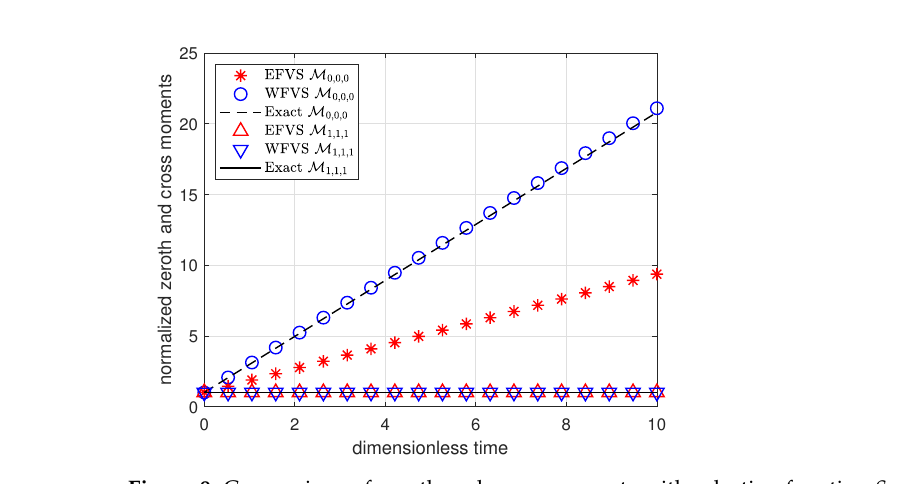
Figure 9. Comparison of zeroth and cross moments with selection function S = ψ ( x ) , and breakage function b 7 . Table 17. Relative error for the weighted moments at different grid points for the test case with S = ψ ( x ) and breakage function b 7 at t =